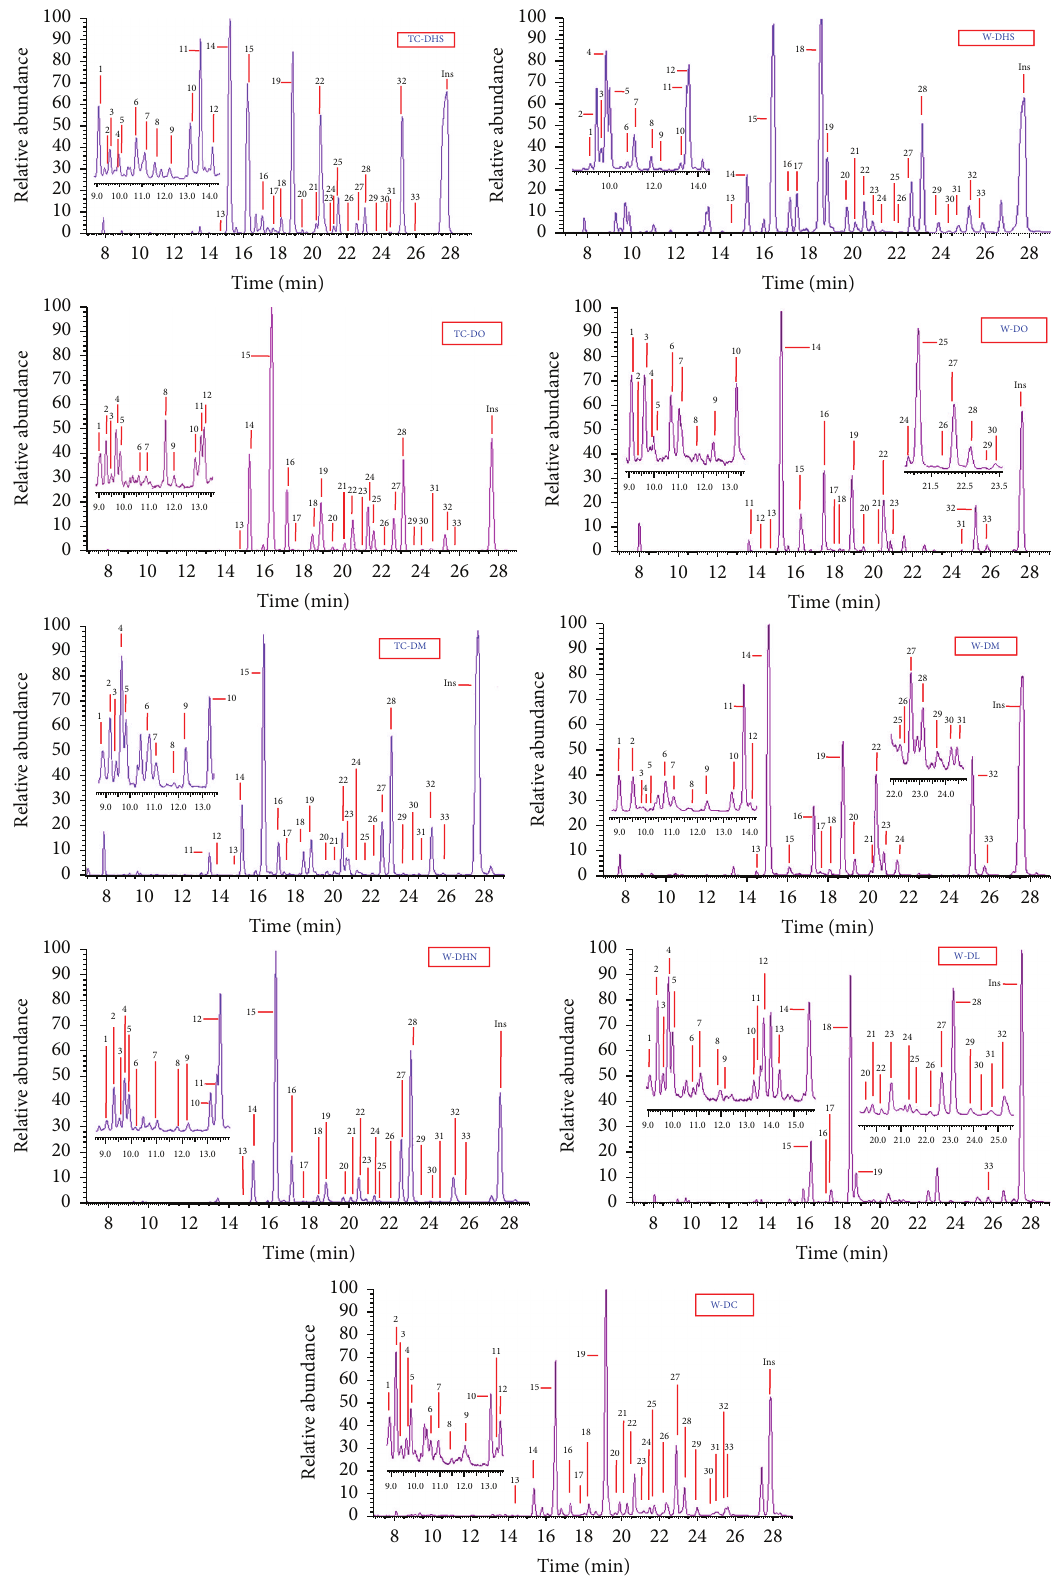
Figure 2: GC-MS comparison of the monosaccharides in the polysaccharides from the nine Dendrobium samples by TMS methyl method. Arabinose (peaks 1, 2, 5, 6, and 8), rhamnose (peaks 3, 4, 7, and 9), xylose (peaks 10–13), mannose (peaks 14–16 and 19), galactose (peaks 17, 18, 20, and 21), glucose (peaks 22, 28, 29, and 32), galacturonic acid (peaks 23–26, 30, and 31), and fucose (peaks 27 and